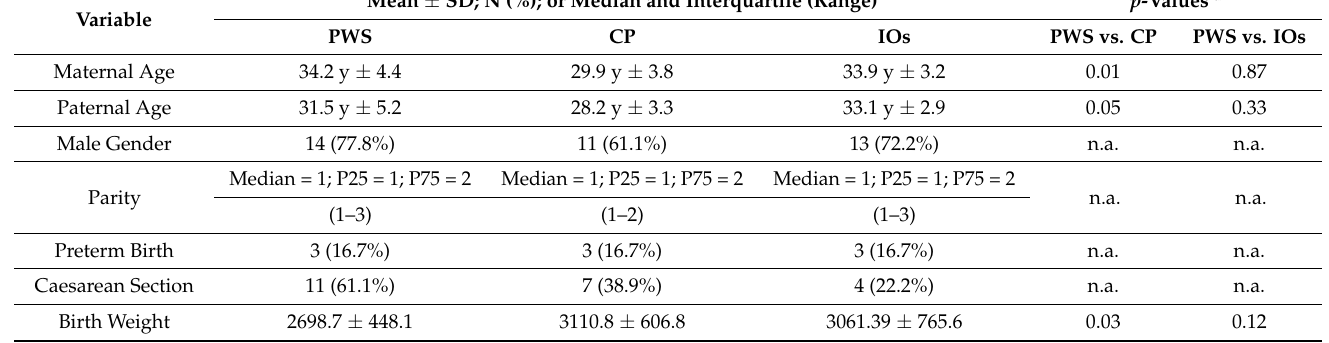
Table 1. Demographical and clinical characteristics of infants with Prader-Willi syndrome (PWS), cerebral palsy (CP), or inconspicuous developmental outcomes (IOs). Each group had 18